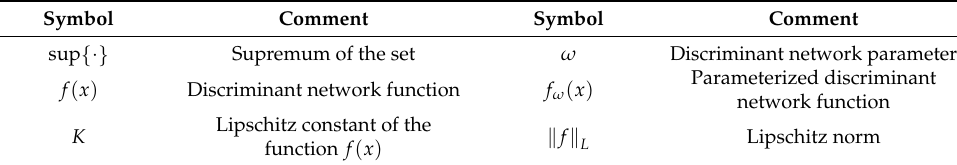
Table 3. Parameters in the mechanical